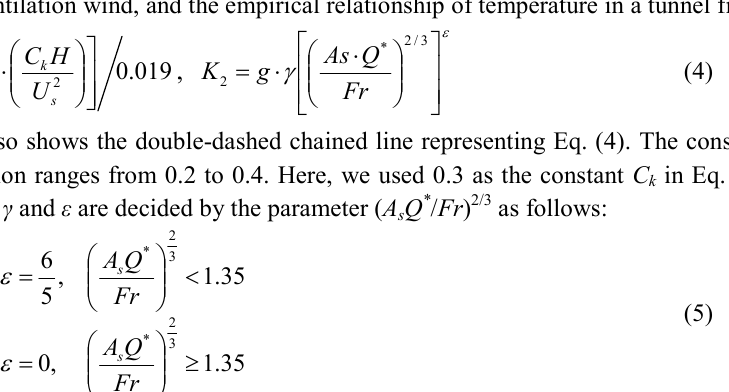
The double-dashed chained line representing Eq. (4) is in agreement with the black circle in the case of Q m* = 0.0316 as shown in Fig. 7. Furthermore, Eq. (4) is in agreement with our newly proposed Eq. (3). The parameters d and e in Eq. (3) were determined based on the fire experiments using the large-scale model tunnel. Likewise, Hu et al. determined the parameters γ and ε of Eq. (4) based on the fire experiments of a full-scale tunnel: a two-lane horseshoe tunnel of 7.2 m in height, 10.8 m in width, and aspect ratio of 1.5. As a result, Eq. (3) and Eq. (4) are similar to each other, as shown in Fig. 7. * and L / H when the Froude number is Figure 8 shows the relationship between Q m b 0.319. The dimensionless backlayering distance increases as the dimensionless heat release rate increases. The dimensionless backlayering distances indicated by the solid line and the double-dashed chained line have a tendency to approach about 20 when the dimensionless heat release rate is in excess of 0.2. Moreover, the backlayering distance calculated by Hu et al.’s Eq. (4) is longer than that calculated by our newly proposed Eq. (3) in all ranges of * . Equation (3) is in agreement with the black circle showing the experimental results Q m * from 0.0316 to 0.111. However, both over a range of the dimensionless heat release rate Q m Eq. (3) and Eq. (4) overcalculate the backlayering distance when the dimensionless heat / H to release rate is not less than 0.111. This is because the proportionality coefficient of L b * = 0.182, as shown in Fig. Q *1/3 / Fr becomes small when the heat release rate Q m